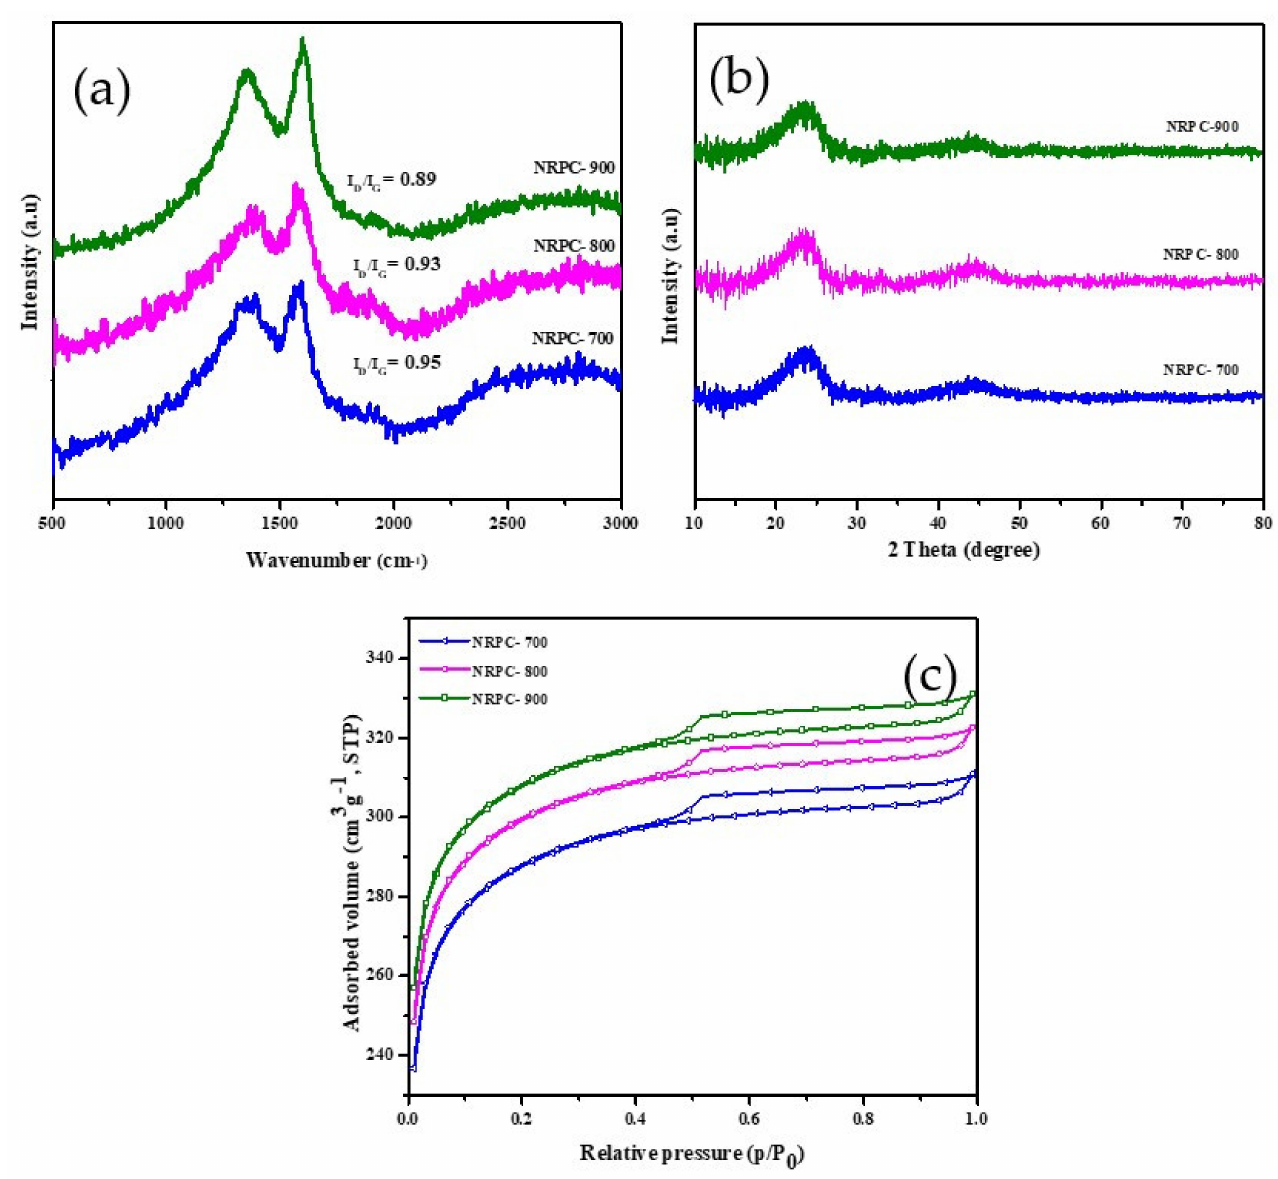
Figure 1. ( a ) Raman spectra, ( b ) XRD and ( c ) N2 adsorption isotherms of NRPCs. Nitrogen adsorption-desorption isotherms of the activated carbons are shown in Figure 1c. It could be seen that all the activated carbons—NRPC-700, NRPC-800 and NRPC- 900—exhibit type IV isotherms with similar hysteresis loops in the mesopore range. A sharp rise in N 2 isotherms were observed at a relative pressure below 0.1, representing micro-pore adsorption, which increases along with increased activation temperature. When compared with NRPC-700 and NRPC-800, the NRPC-900 sample showed a wider micropore size distribution which might be due to the higher activation temperature. A steady increase of adsorption isotherms were observed with increasing relative pressure up to P/P o = 0.9, which might be due to the gradual adsorption of N 2 molecules on the mesopores